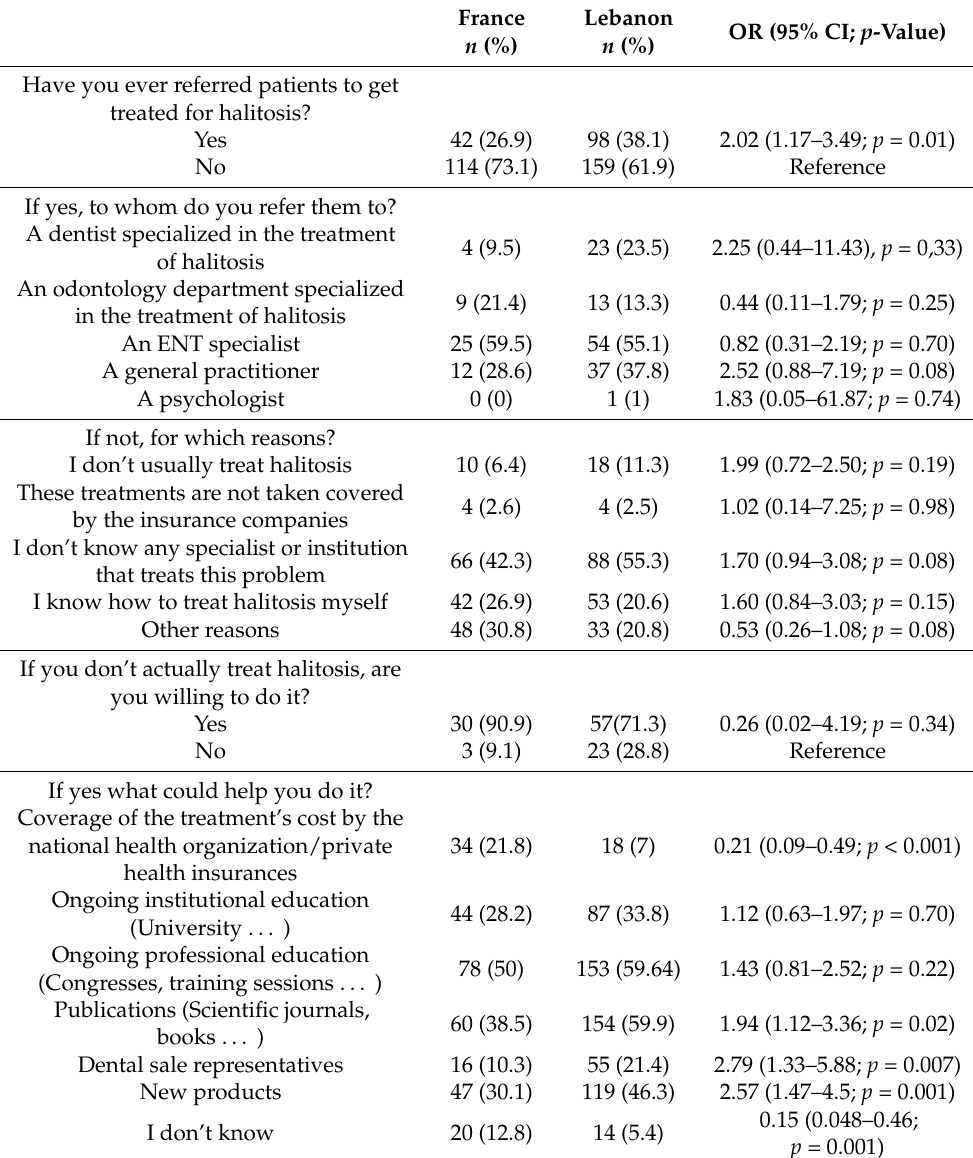
Table 4. Referral and need for education. Difference between LD and FD when adjusted for gender, age, and professional experience. A p < 0.05 was considered significant. (OR: odds ratio, CI: confidence